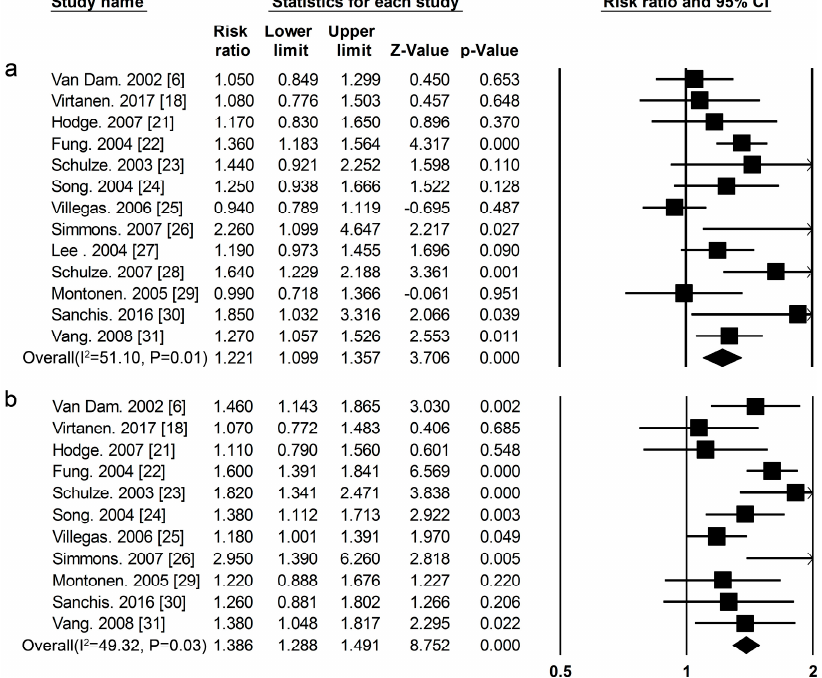
Figure 5. ( a ) Red meat ( b ) processed meat and type 2 diabetes RRs for the highest vs. the lowest intake in all subjects. The RR of each study is represented by a square, 95% CI are represented by the horizontal lines, and the diamond represents the estimate and its 95% CI.